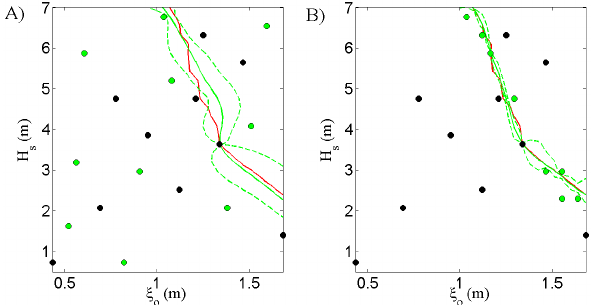
Figure 6. Best estimate of the two-dimensional 0 c (green solid line) in the { ξ o ; H s } domain. The corresponding pair of contours at confi- dence level of 95% (defined as the kriging mean (Eq. 2) ± twice the square root of the variance (Eq. 3)) is represented by green dashed lines; The red solid line is the reference contour. (A) The training data are composed of an initial budget of 10 samples (black dots) and 10 additional samples (green dots) both selected using LHS technique. (B) The training data are composed of an initial budget of 10 samples (black dots, as for the case with no adaptive sampling) and 10 additional samples (green dots) adaptively selected.